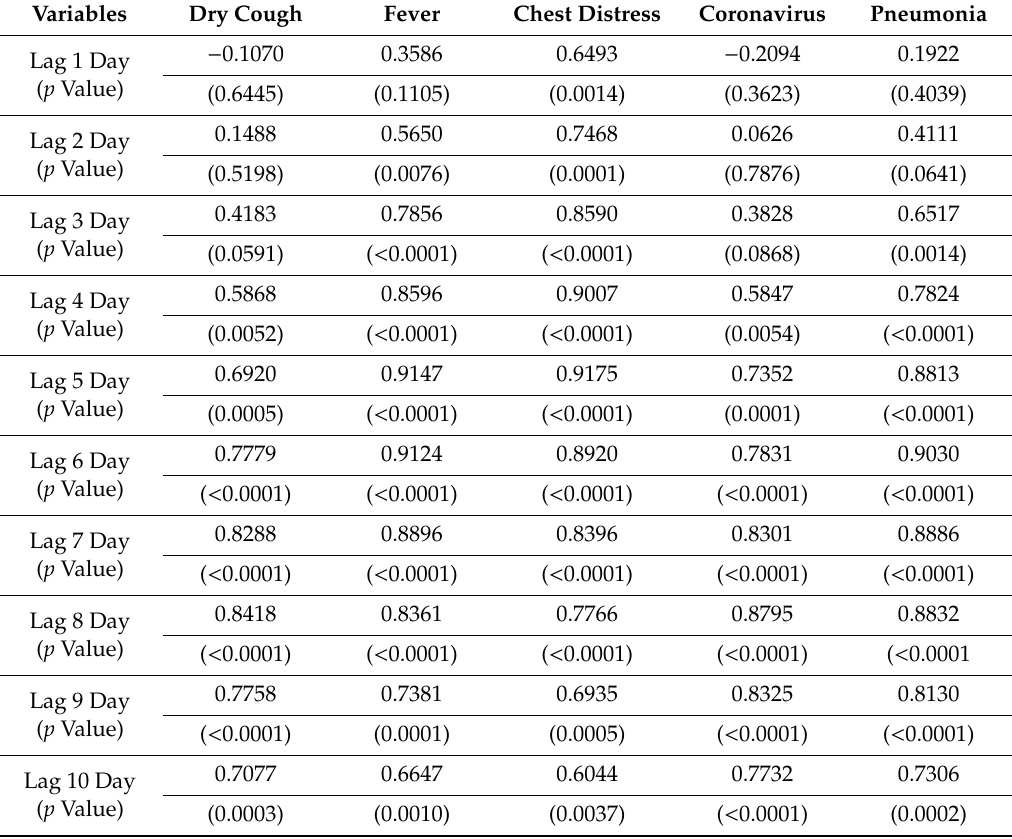
Table 1. Correlation between new suspected Coronavirus disease 2019 (COVID-19) case number and lag value of five keywords in Baidu search index (BSI).